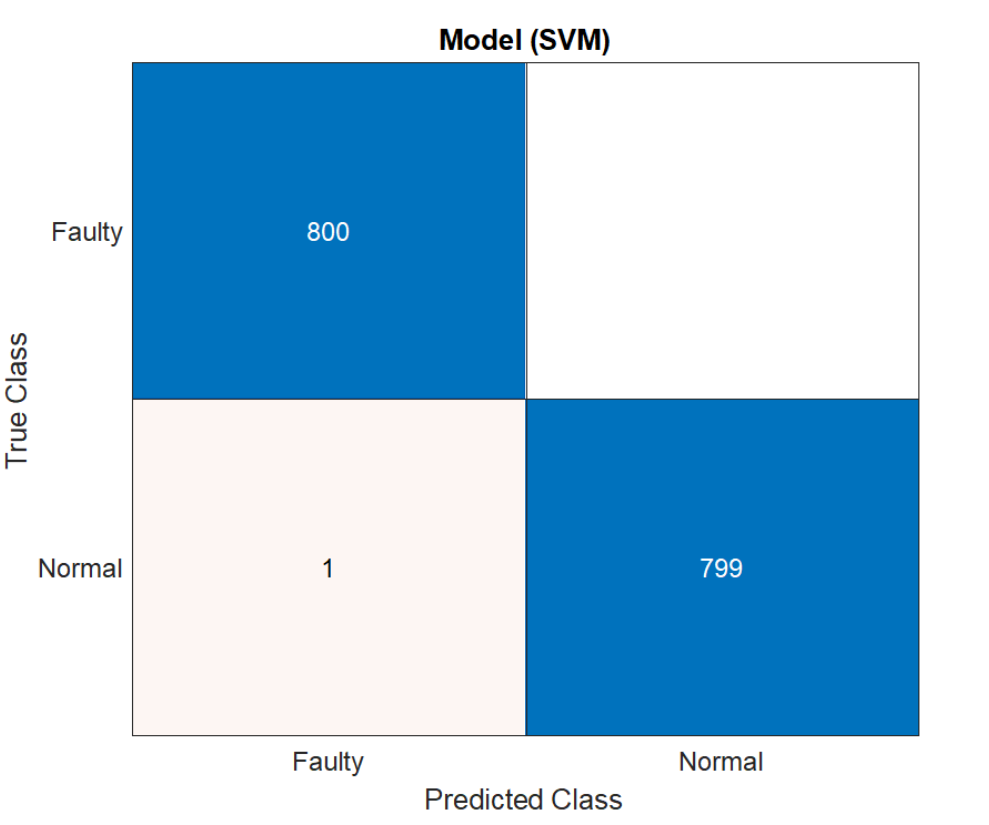
Figure 21. Confusion matrix for the highest-scoring classifier (SVM) for Robostar fault